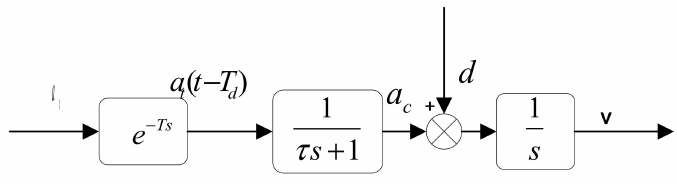
Figure 12. Controller